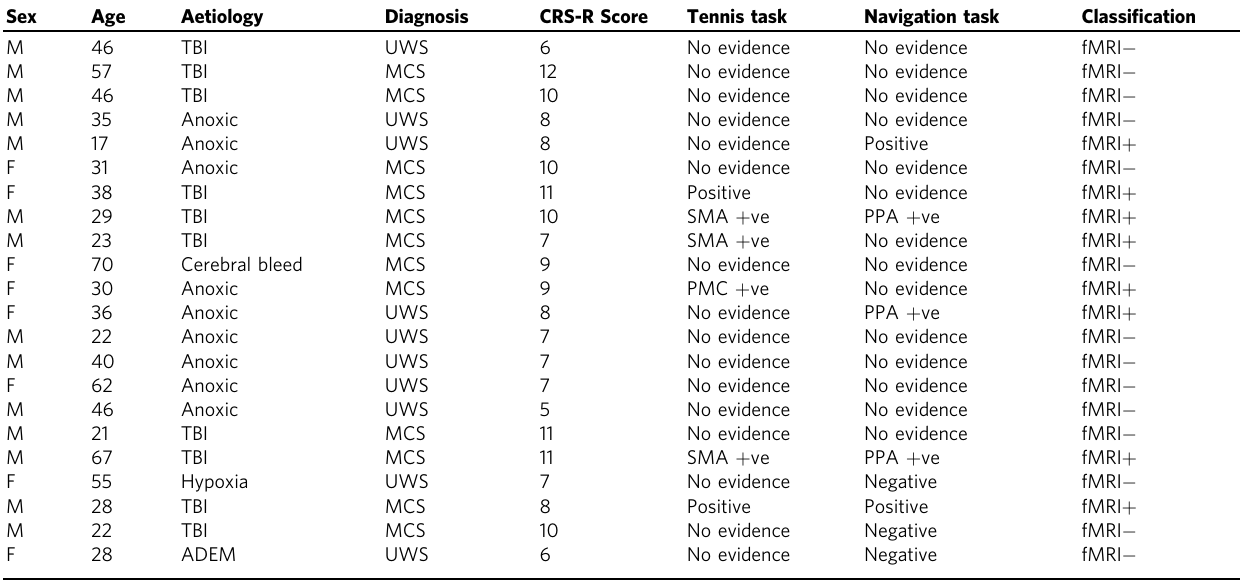
Table 1 Demographic information for patients with disorders of